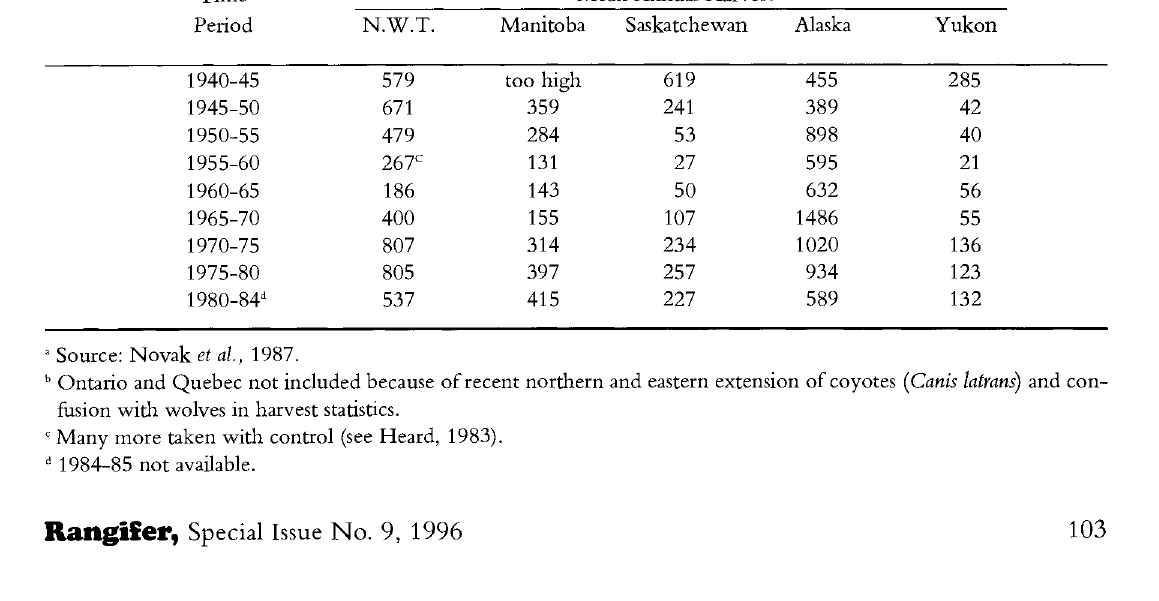
Table 5. The mean annual harvests of wolves by 5 year winter intervals.